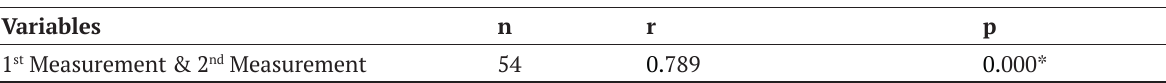
Table 4. Correlation analysis between measurement values of the experimental group (Paired Samples Correlations)